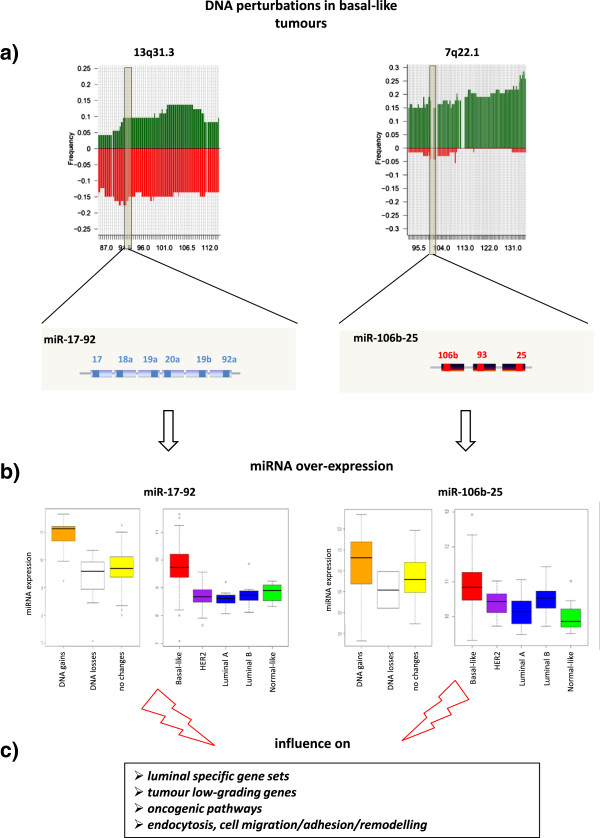
Summary of the integrated genomic analysis of miR-17-92 and miR-106b-25 clusters. (a) DNA gains and losses respectively occurring in the miRNA clusters genomic locations. Frequencies of DNA gains (Y axis, green colour) and losses (Y axis, red colour) along the genome sequence (X axis) are represented. Data refer to the selected sub-cohort of basal-like tumours. (b) DNA gains in genomic regions 13q31.3 and 7q22.1 drive the up-regulation of the respective miRNA clusters in basal-like tumours. The two paired panels show miRNA cluster expression across tumours with DNA gains (orange), losses (white), no changes (yellow) of the respective loci (left) and different intrinsic subtypes (right) (c) down-stream effects observed to be driven, at the transcriptional level, by the up-regulation miR-17-92 and miR-106b-25 clusters in basal-like tumours.